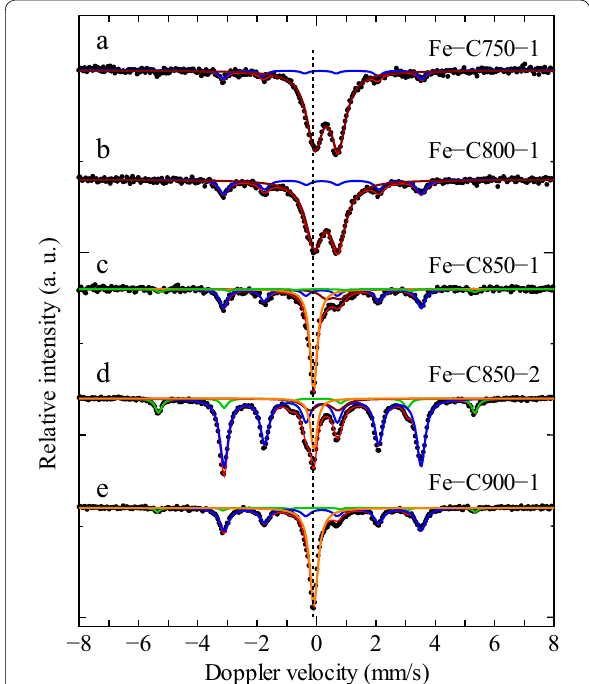
Fig. 3 Mössbauer spectra at 298 K of iron-loaded charcoal samples: a Fe-C750-1; b Fe-C800-1; c Fe-C850-1; d Fe-C850-2; e Fe-C900-1; Brown solid curve (Doublet): high-spin Fe 3 + species, Blue solid curve (Sextet 1): Fe 3 C, Green solid curve (Sextet 2): α-Fe, Orange solid curve (Singlet): γ-Fe, Red solid curve (Overall spectral line), Vertical black dotted line: IS of